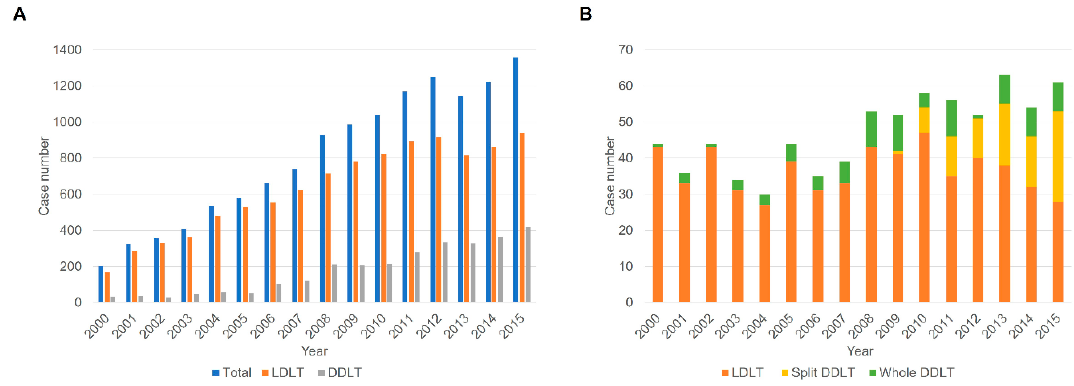
Figure 2. Annual number of ( A ) total liver transplantations (LT) including adult and children and ( B ) pediatric LT alone.